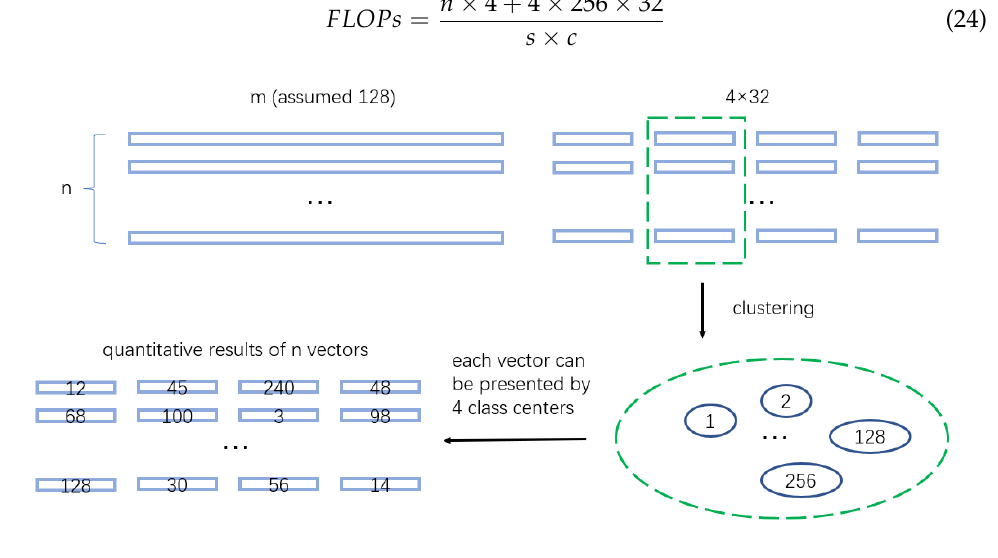
Figure 5. Details of Product